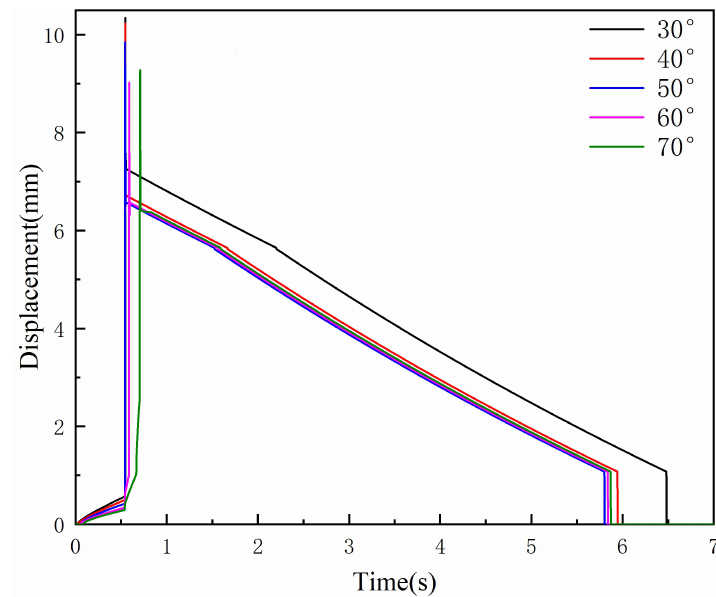
Figure 9. Relative displacement of the release